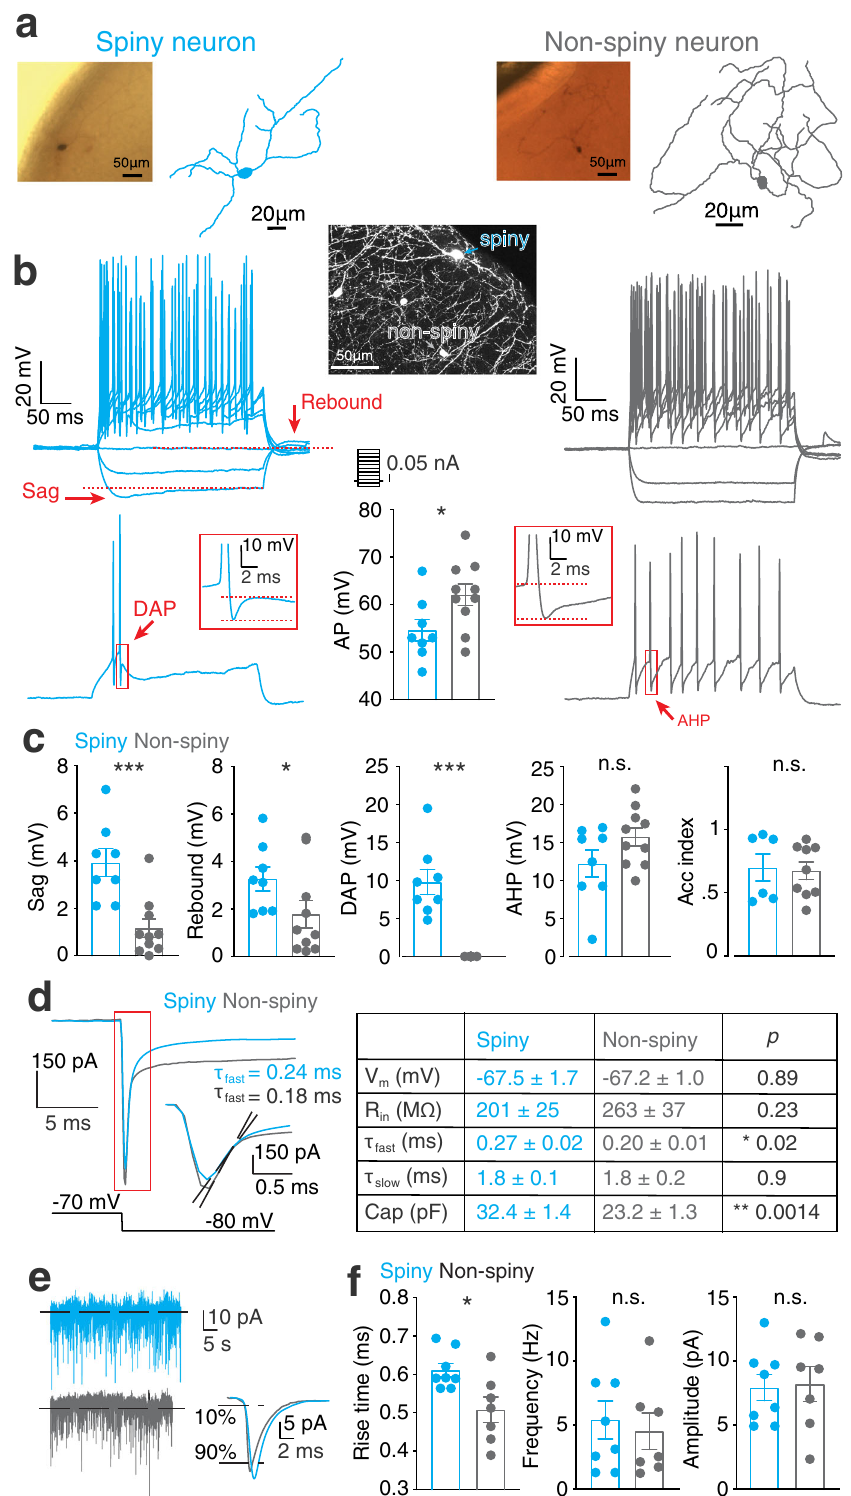
of super fi cially located burst-spiking VIP cell populations 49,50 , which may predominantly consist of CCK-expressing neurons 50 . Dendritic spines on VIP neurons are dynamic . To study the dynamics of VIP spines we repeatedly imaged 16 dendrites in 5 mice over a maximum period of 54 days with a minimum